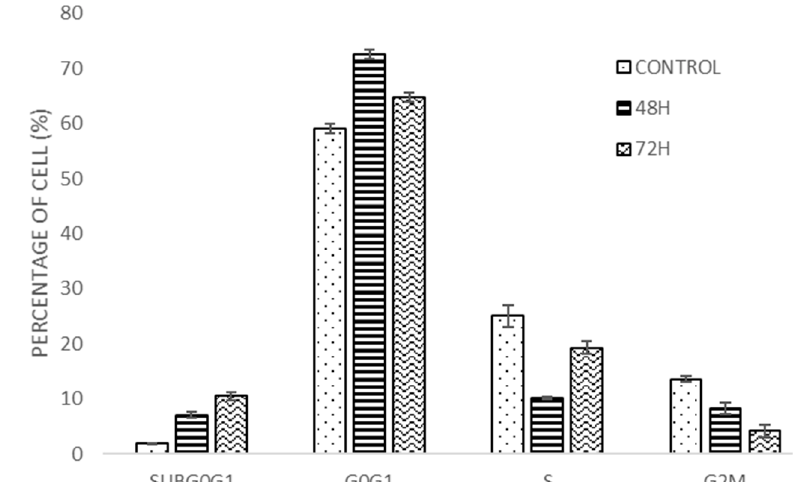
Figure 4. Cell cycle histogram and bar chart analysis for HT-29 after being treated with DMCH for two time periods (48 h and 72 h). All data are expressed as mean ± standard error mean (S.E.M.).